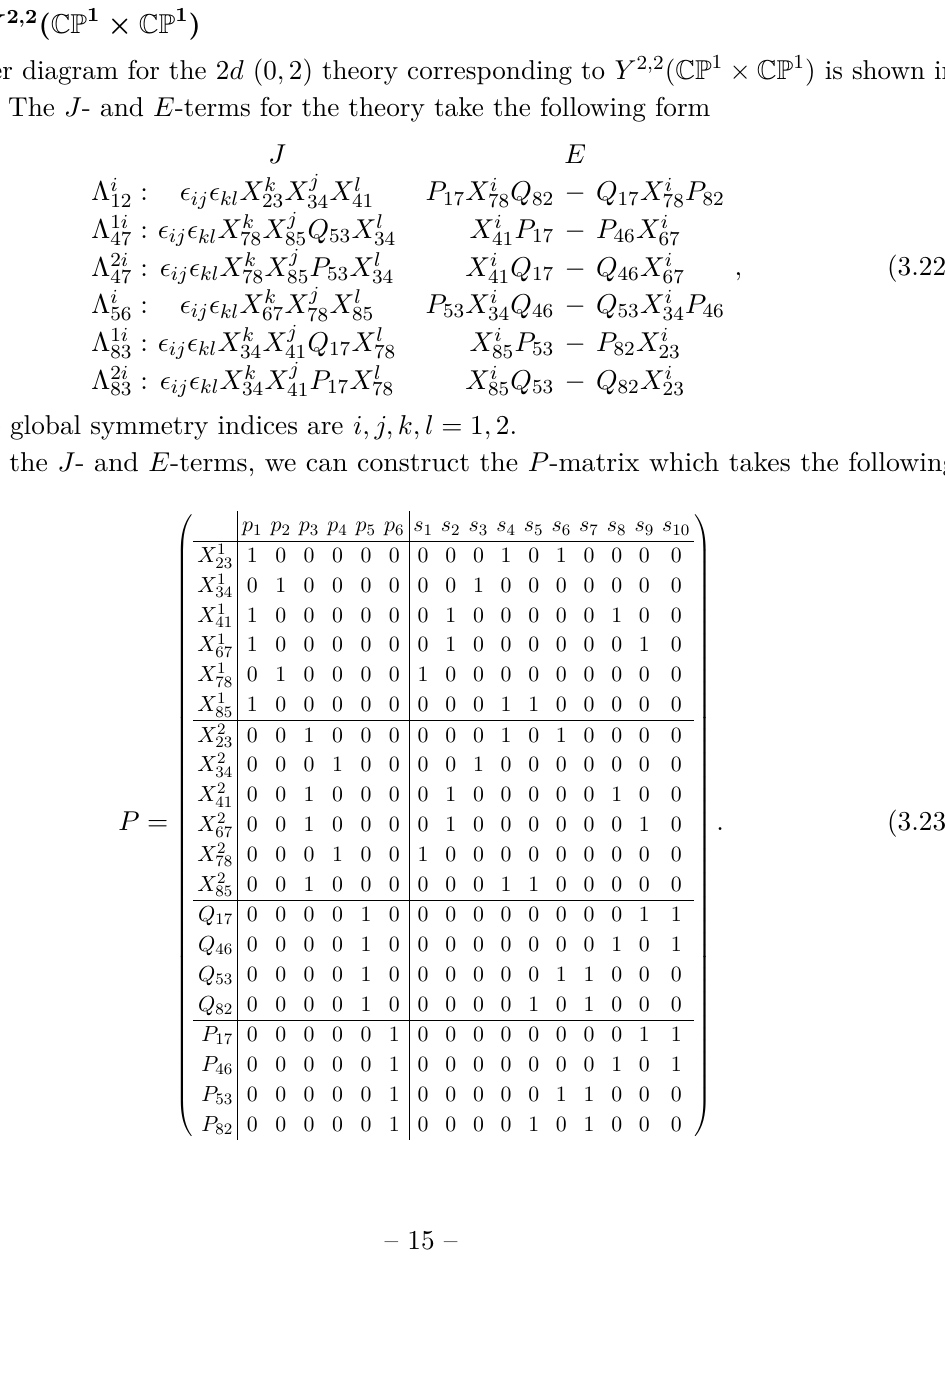
Figure 9 . Toric diagram of Y 2 , 1 ( CP 1 × CP 1 )